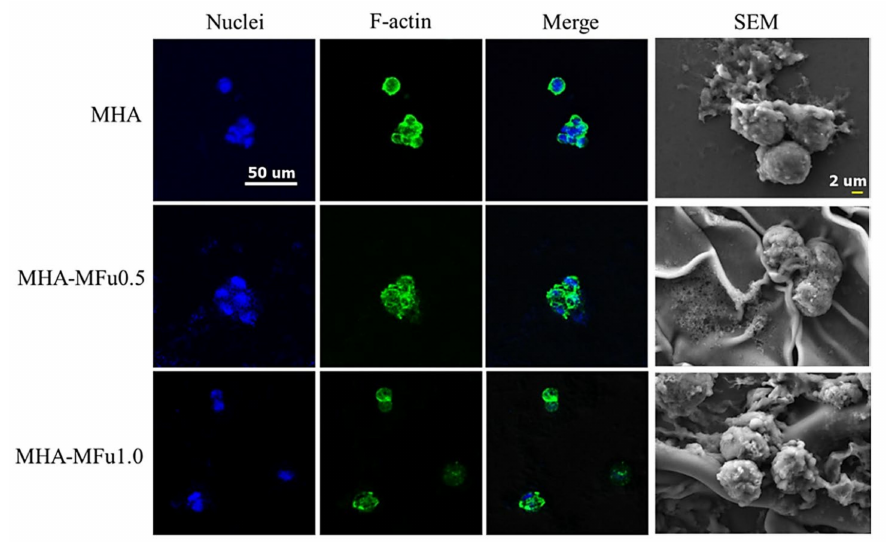
Figure 9. SEM and immunofluorescence assessment of cell morphology on MHA-MFu and MHA hydrogels after 7 days. Scale bar: 2 µ m for SEM and 50 µ m for immunofluorescence images